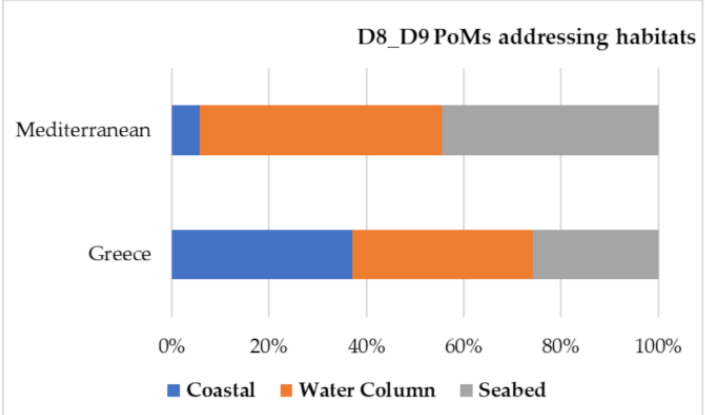
Figure 16. Habitats to which the Greek and Mediterranean MSs’ measures established under Con- taminants Descriptors